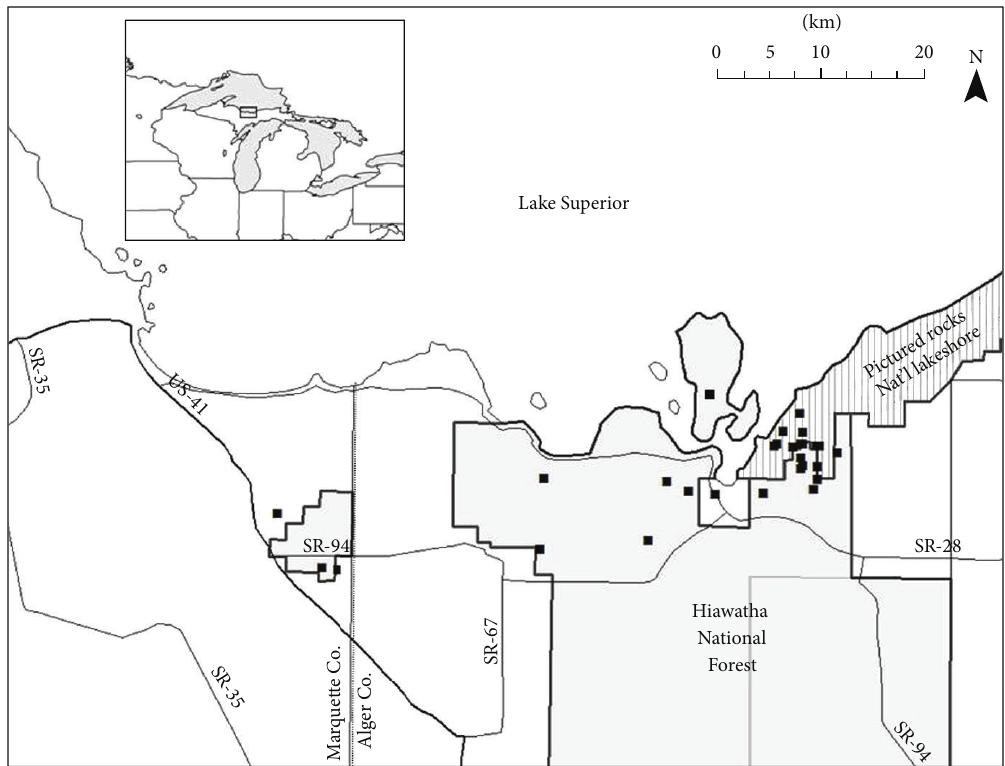
Figure 1: Distribution of study sites (black squares) in Marquette and Alger counties, Michigan, USA. Inset shows location of study area in relation to the Great